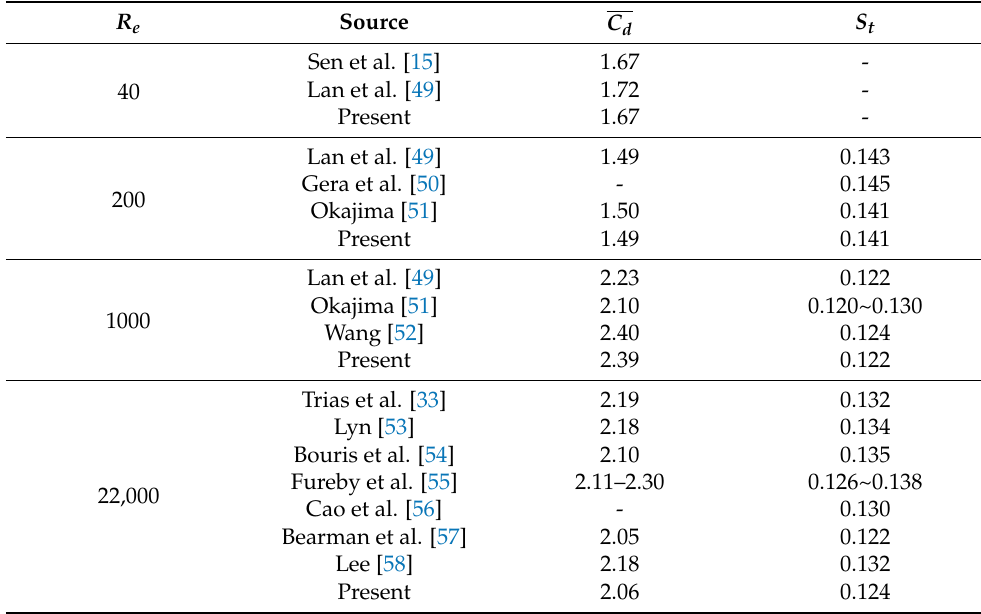
Table 4. Comparison of C d and S t of the flow around a square cylinder under different R e values between the present and earlier